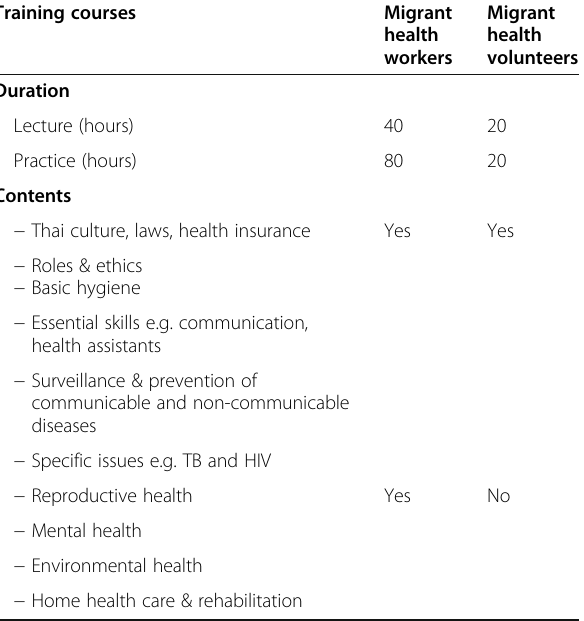
Table 4 MHW and MHV training courses Training courses Migrant